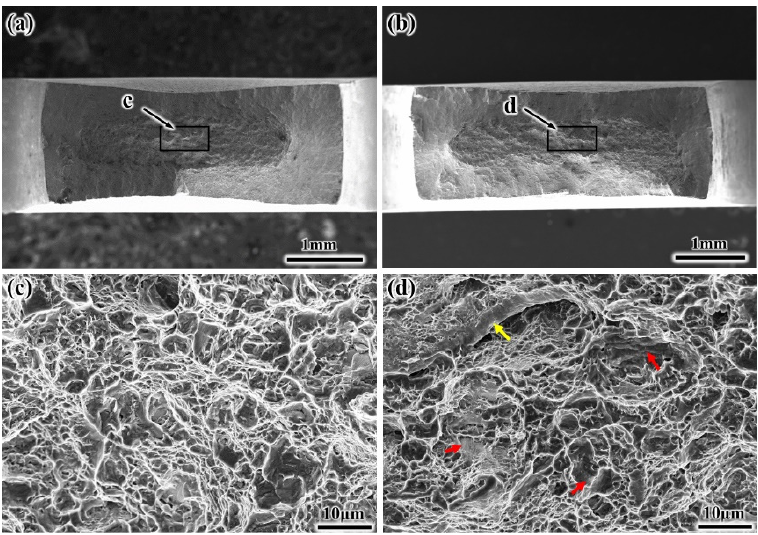
Figure 13. Fractographs of TA19 titanium alloy specimens with the EM and S-EM after tensile deformation showing a mixed failure mode: ( a , c ) EM and ( b , d ) S-EM. Combined with the in situ tensile test, it is found that the approximately 3 μ m crack first initiates at GB α of the S-EM when the strain is 11.8% (Figure 14). In contrast, the crack first initiates at the α p / β trans interface in the EM when the strain is 8.3%. Therefore, some GB α precipitates on the β grain boundary in the S-EM, which is an important factor that causes early fracture and ultimately leads to the decrease in plasticity [29].